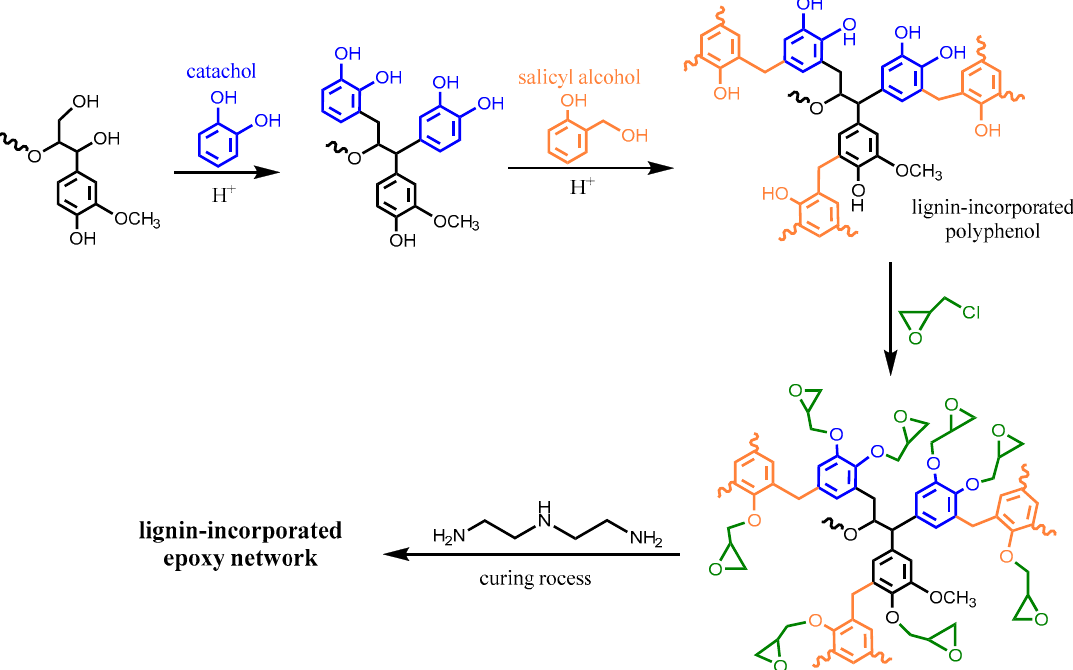
Figure 6. The synthetic route of liquid lignin-incorporated polyphenol from acid-catalyzed phenolation and formaldehyde-free oligomerization. Adapted from [38] with permission from American Chemical Society © 2020.